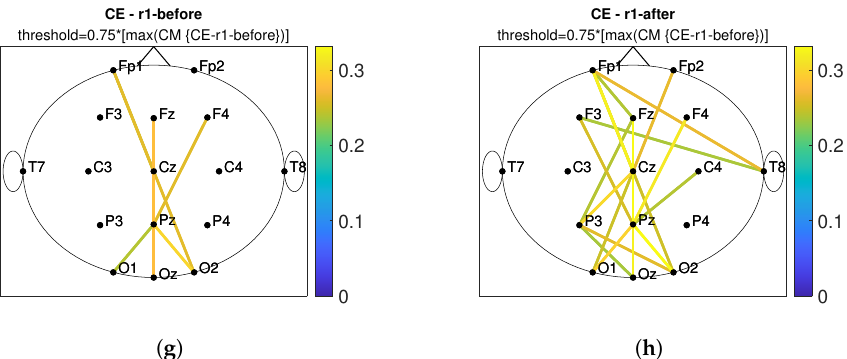
Figure 11. The short-term effect of PBM stimulation in observing the connectivity values of imCPCC at the r 1. The connectivity matrices ( CM ) and the head plot of the connections above threshold between electrode pairs are observed. ( a ) shows the CM under the OE condition before stimulation and ( c ) shows the headplot of the connections, while ( b , d ) show the CM and the headplot of the connections after stimulation. ( e – h ) show the CM or the headplot of the CE condition.